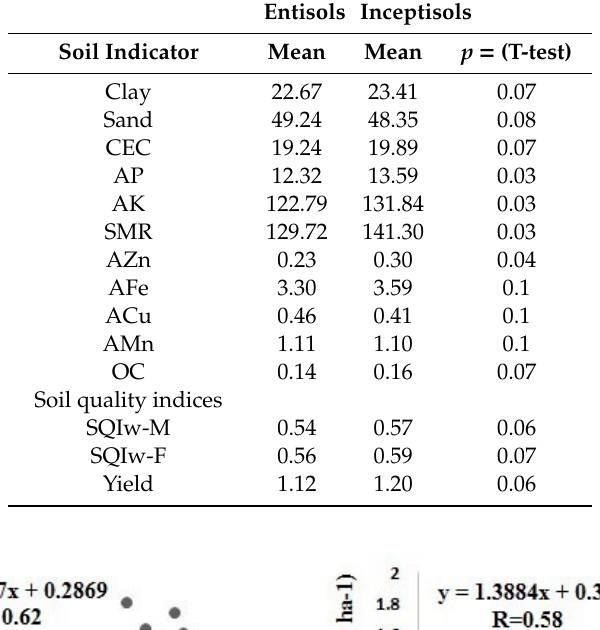
Table 7. Results of independent samples t-test for soil properties and SQIs.